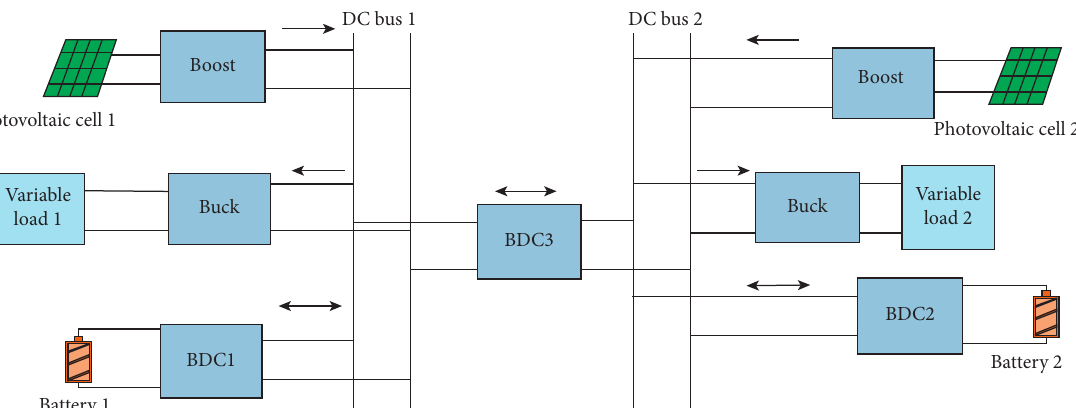
Figure 1: Topology of DC microgrid cluster.